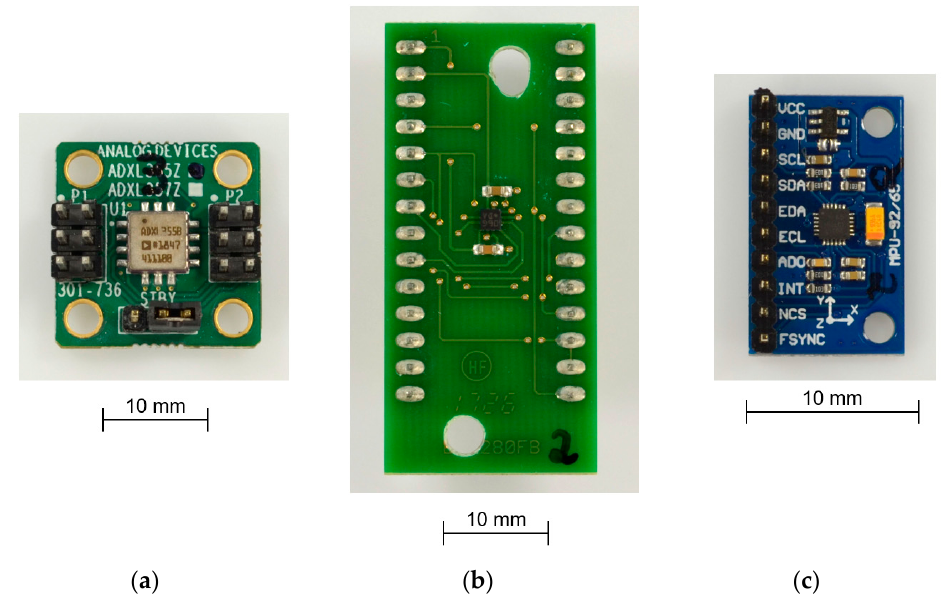
Figure 3. Sensors with evaluation boards used in this work (not to scale): ( a ) Analog Devices ADXL355Z; ( b ) Bosch BMA 280; ( c ) TDK InvenSense MPU6500.